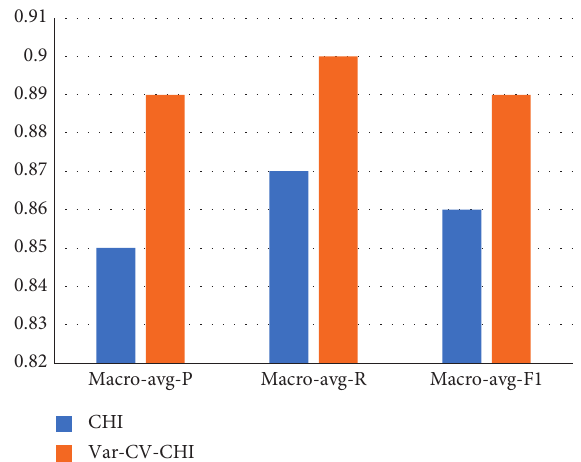
Figure 8: Comparison of macroresults between CHI and Var-CV- CHI on the unbalanced English corpus (Na¨ıve